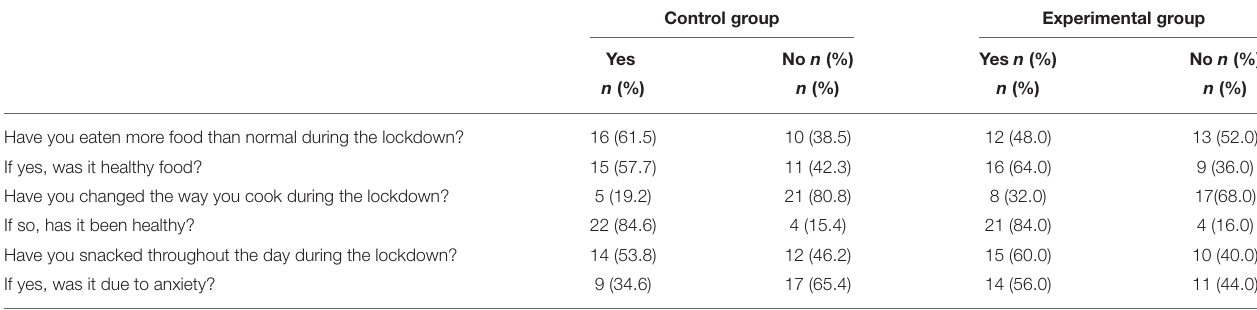
TABLE 4 | Eating behavior during the lockdown in the control group and the experimental group.